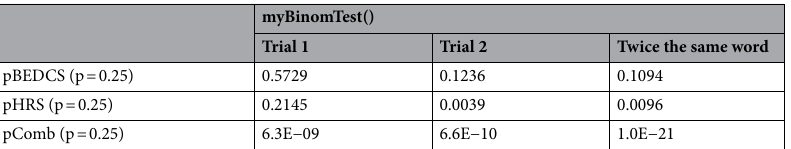
Table 2. The MATLAB function myBinomTest() was used to test whether performance is above chance. Performance was not above chance for the test with BEDCS alone. With the HR-Stream, performance was above chance for the second trial and twice the same word. Performance was significantly above chance for the combined performance